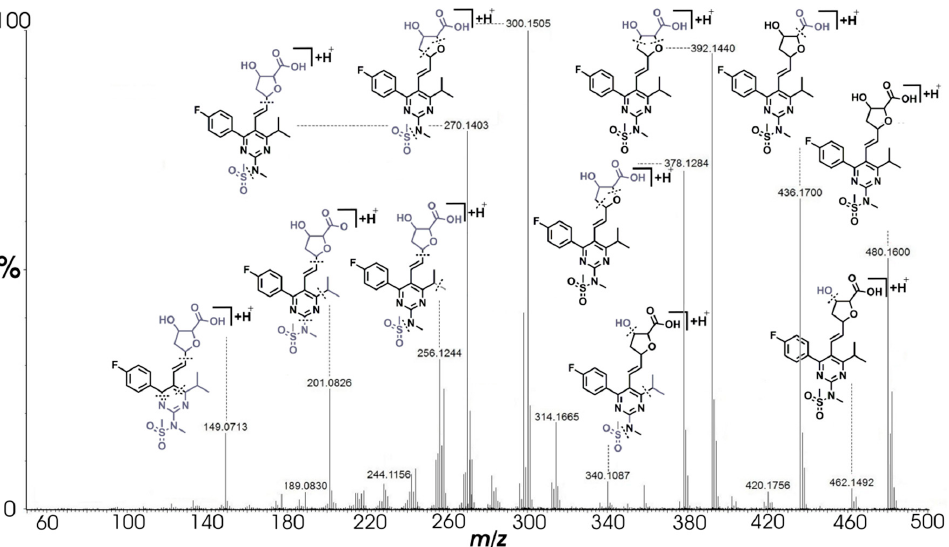
Figure 8. Fragmentation MS/MS spectra of product E [M + H] + ion (precursor ion mass m/z 480.1600) obtained by using collision energy of 25 V.